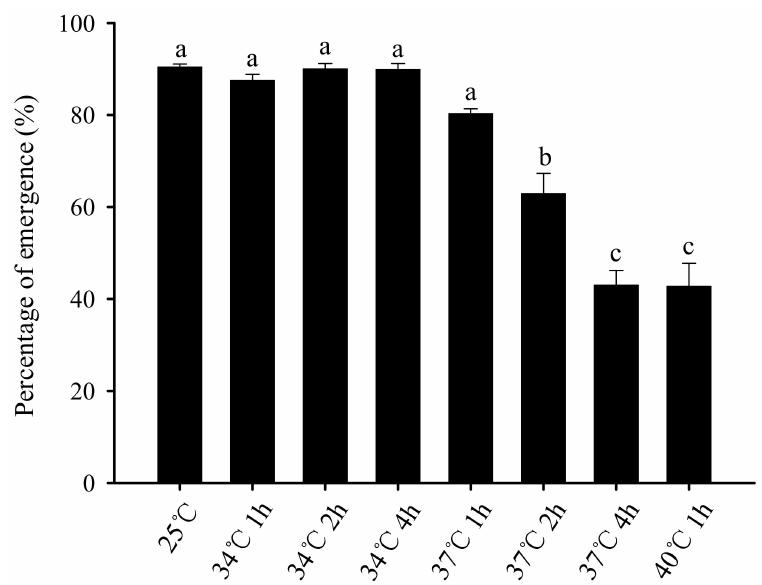
Figure 3. E ff ect of short-term high-temperature stress on the eclosion rate of subsequent pupae of third-instar Bradysia odoriphaga larvae. Values are means ± SD of five replicates. Within each panel, bars with di ff erent letters are significantly di ff erent according to Tukey’s test ( p < 0.05 ). Each pupa of per replicate was put into a separate Petri dish and was marked. The eclosion was monitored daily. Pupae were counted as dead if they did not start eclosion within 10 days. The total numbers (N) of pupae were 292, 288, 281, 276, 265, 248, 29, and 84 after third-instar larvae exposure to 25 ◦ C or 34 ◦ C for 1 h, 34 ◦ C for 2 h, 34 ◦ C for 4 h, 37 ◦ C for 1 h, 37 ◦ C for 2 h, 37 ◦ C for 4 h, and 40 ◦ C for 1 h,